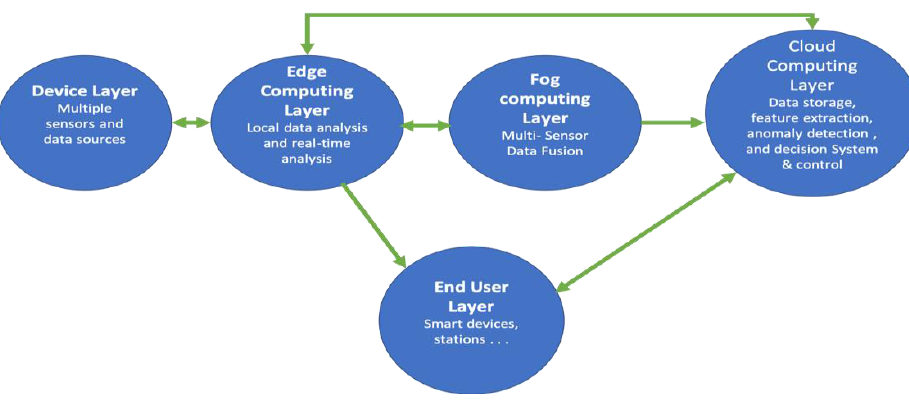
Figure 2. IoT stretched model.